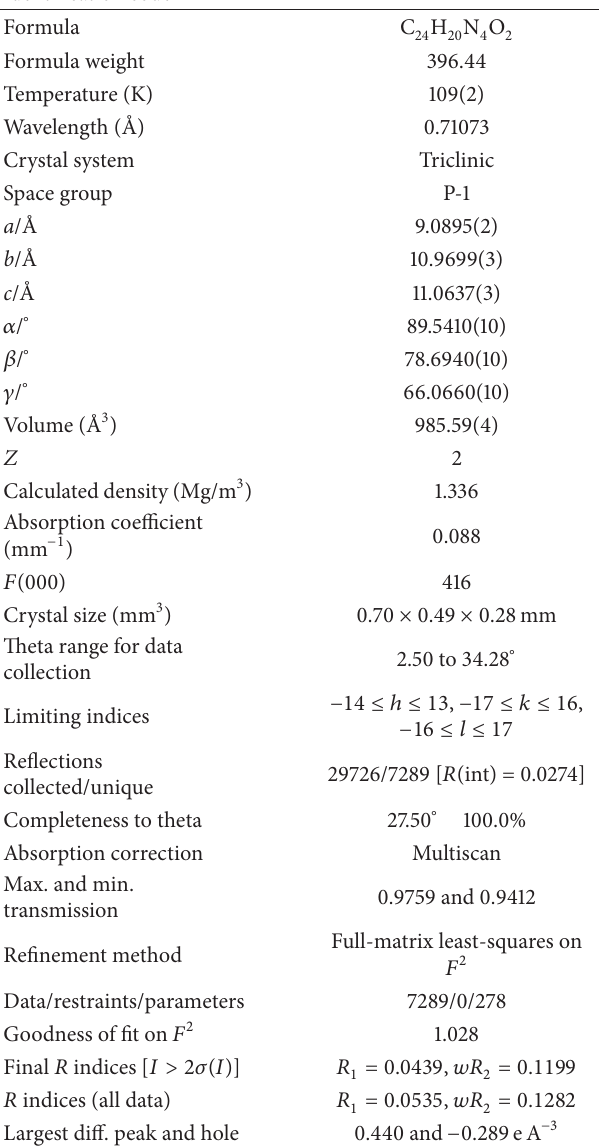
Table 2: Crystal data and structure refinement details for HL 1 .